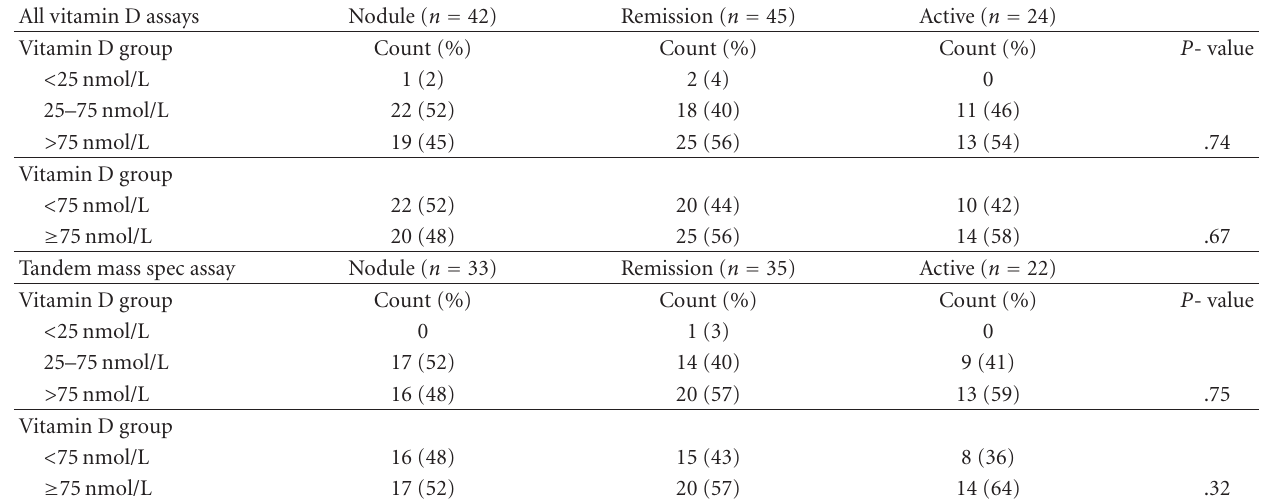
Table 2: Distribution of vitamin D levels for each